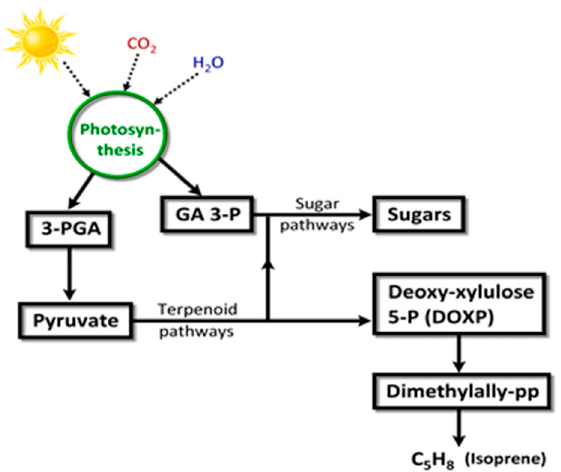
Figure 9. Isoprene production by the DOXP pathway. 3-PGA, 3-phosphoglyceric acid or glycerate 3-phosphate; GA 3-P, glyceraldehyde 3-phosphate. Adapted from [106,108] with